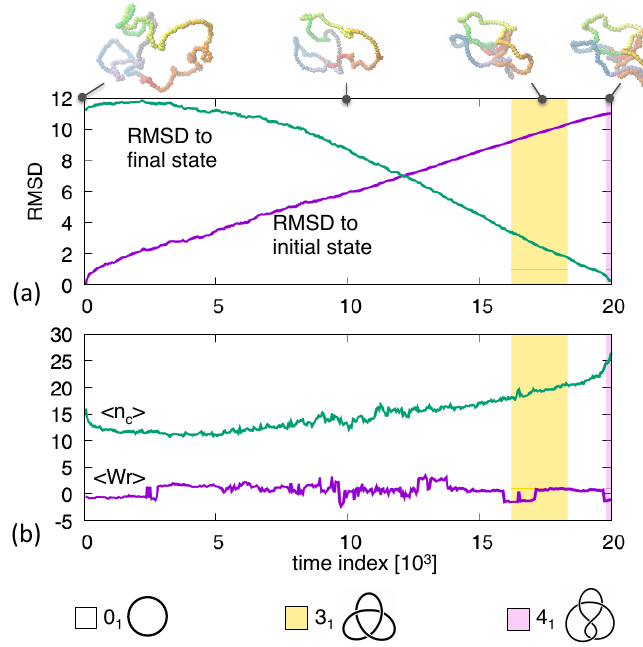
Figure 2. Transition pathway between an unknotted ring and a 4 1 knotted ring. The shown observables are the same as in Figure